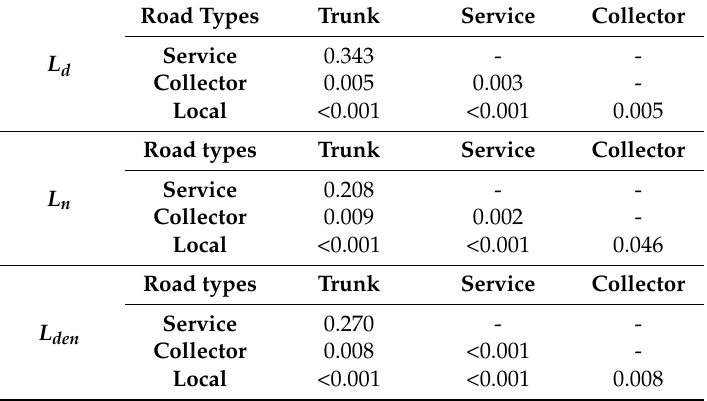
Figure 3. Box plot of L d , L n and L den descriptors registered in each road types. Table 2. p -Values with Holm adjustment of pairwise comparisons of road types using Mann-Whitney U test.